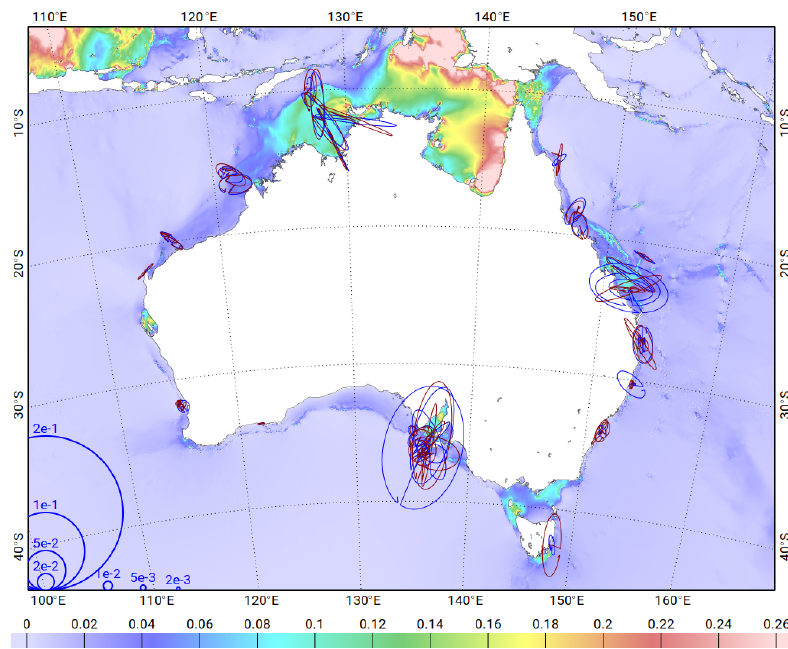
Figure 19. K1 tidal component, tidal velocity ellipses at the 48 current meter stations around Australia for the FES2014b tidal model (blue) and the ADCP observations (red). Ellipses scales are in ms − 1 . Ellipse scales are in ms − 1 . The inside line indicates velocity direction at Greenwich transit time, ellipse rotation from inside line to arrow-terminated ellipse